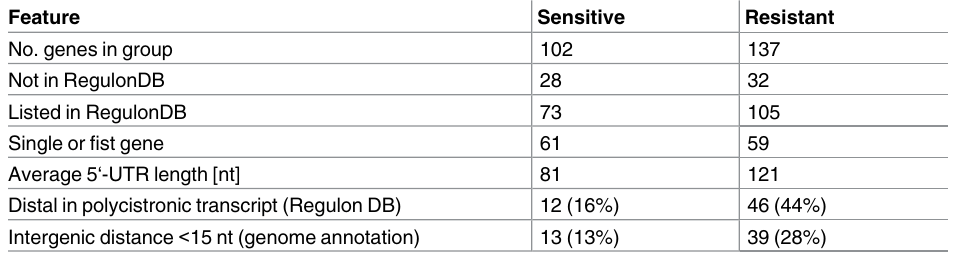
Table 2. Summary of selectedfeatures extractedfrom RegulonDB, which exhibit differences for the groups of Kasugamycin-sensitive versus—resistant genes. The number of genesthat exhibitthe respectivefeature are